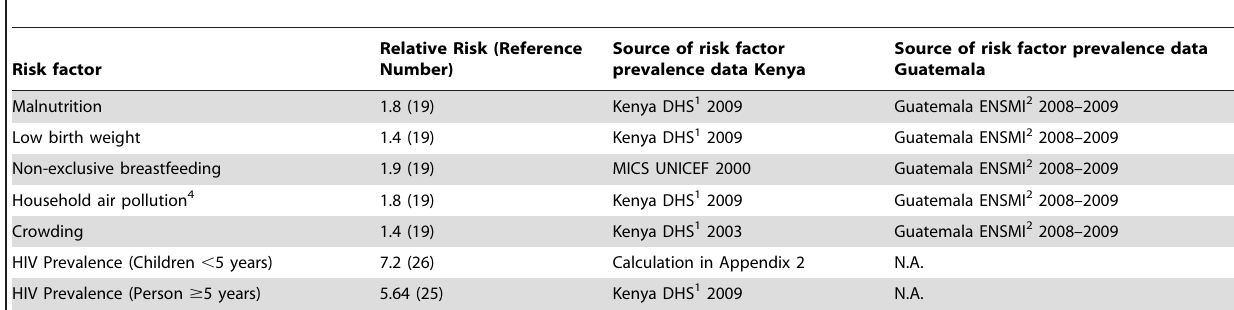
Table 1. Risk factors and associated relative risks of low and lower-middle income severe acute respiratory infection, and sources of data on risk factors by